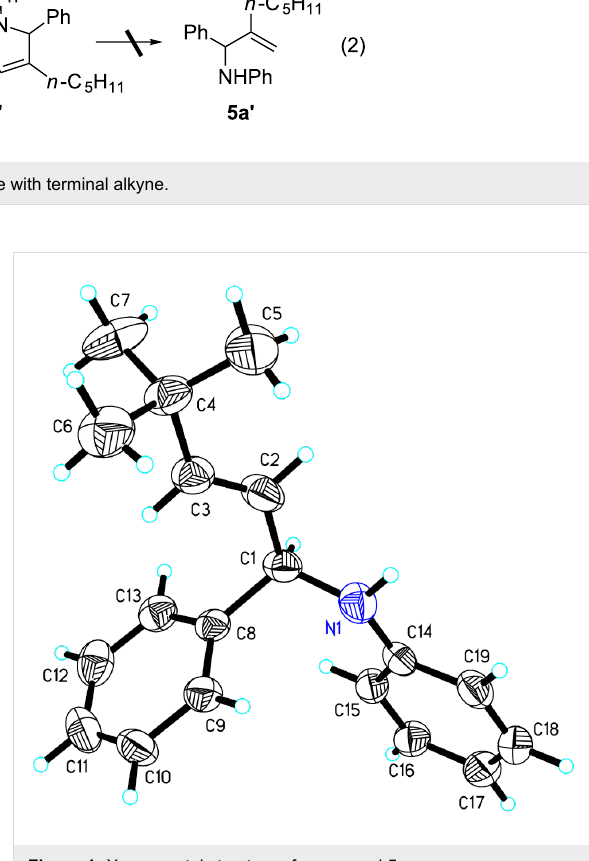
Figure 1: X-ray crystal structure of compound 5c